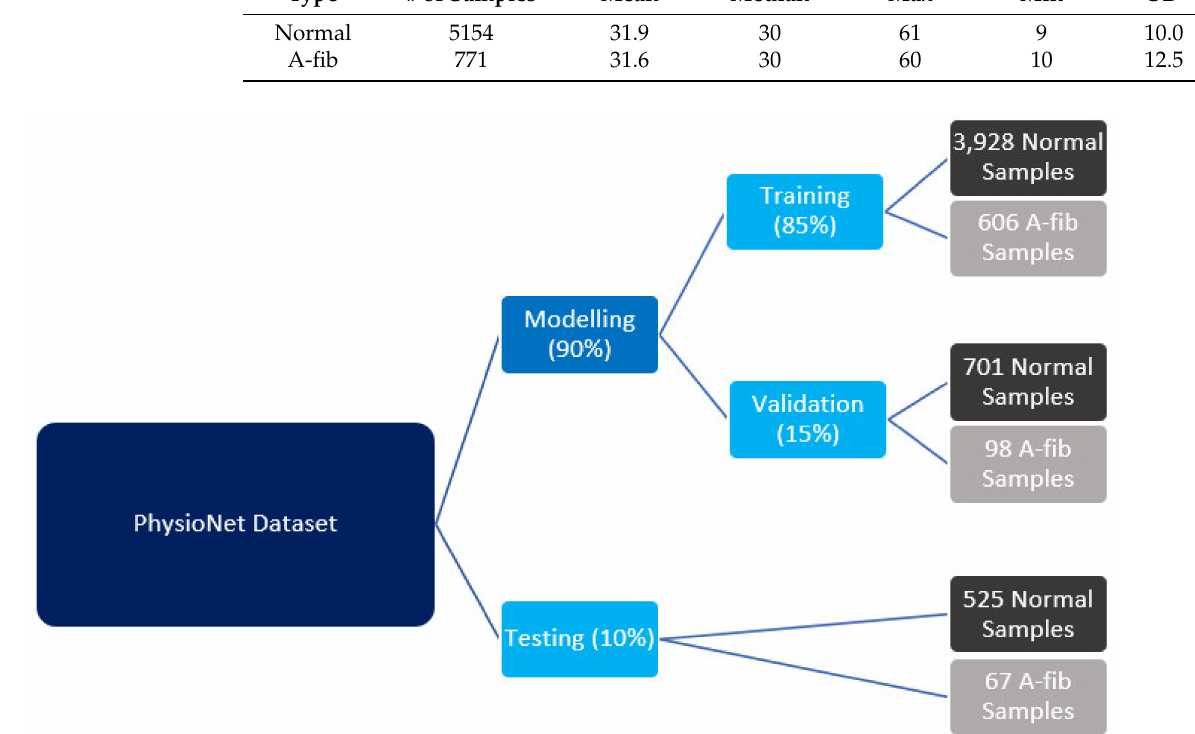
Figure 1. Data split for training, validation, and